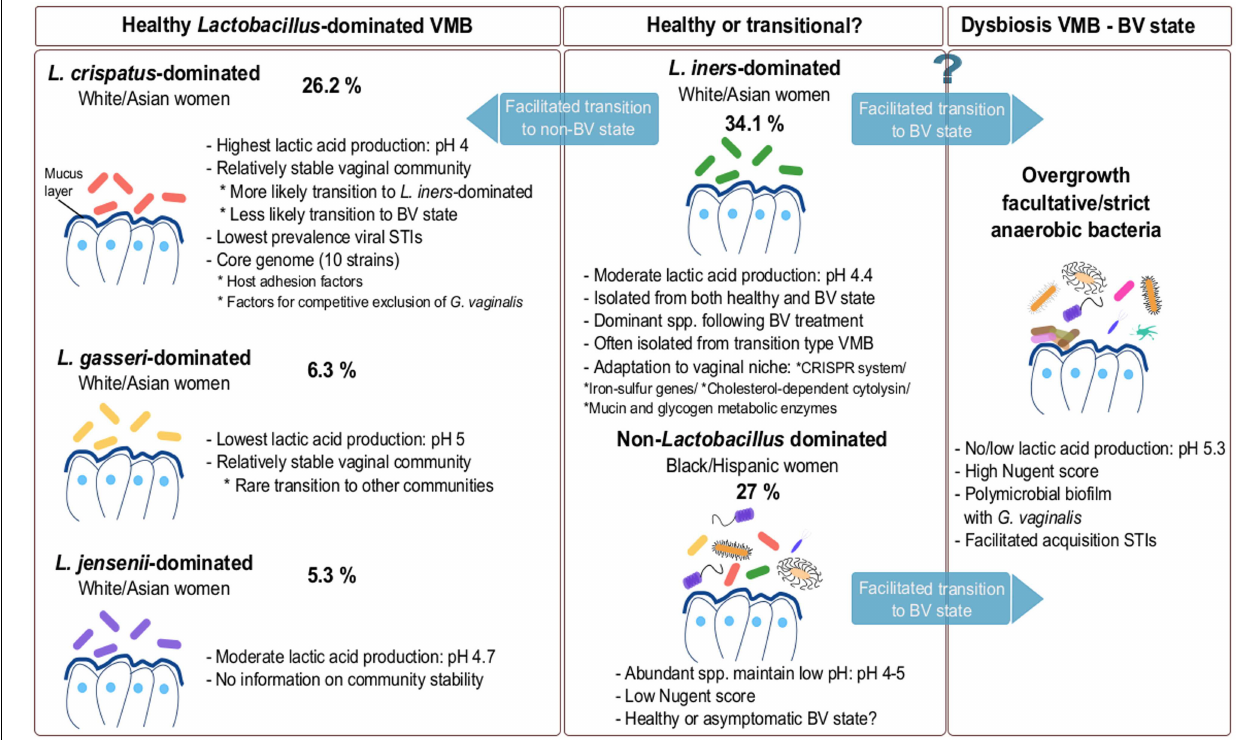
Because this species is often isolated during BV, L. iners may not be able to effectively protect against pathogens. Additionally, a non- Lactobacillus dominated VMB is also documented in various healthy individuals ( Zhou et al., 2004; Ravel et al., 2011; Santiago et al., 2012). For each compositional state, we have added an example of their abundance based on the study of Ravel et al. (2011). However, these numbers are only exemplary and should be considered with caution, as they clearly depend on the study population (size and characteristics) and they certainly need to be substantiated in further